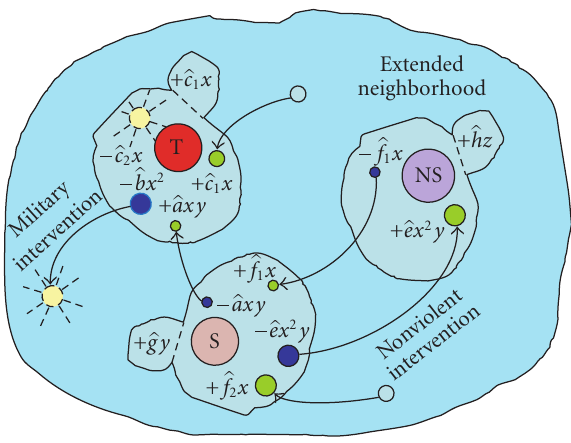
Figure 2.1. Schematic showing the dynamical system described by (2.1), (2.2), and